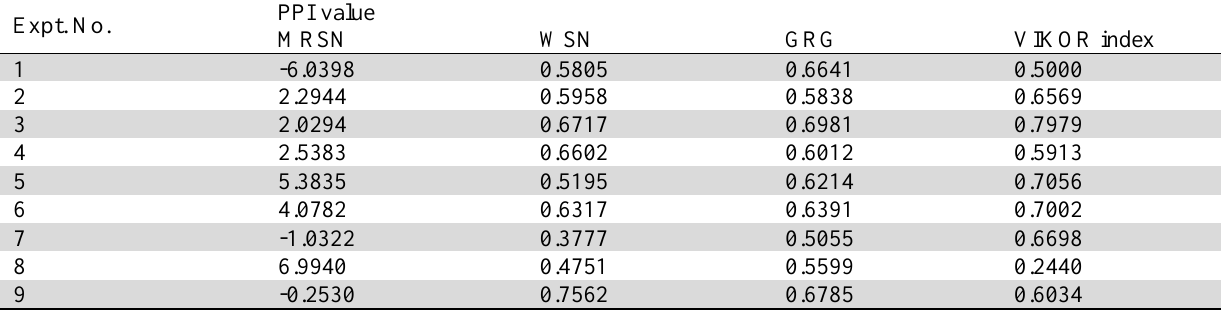
PPI values for MRSN, WSN, GRA, and VIKOR method Expt.